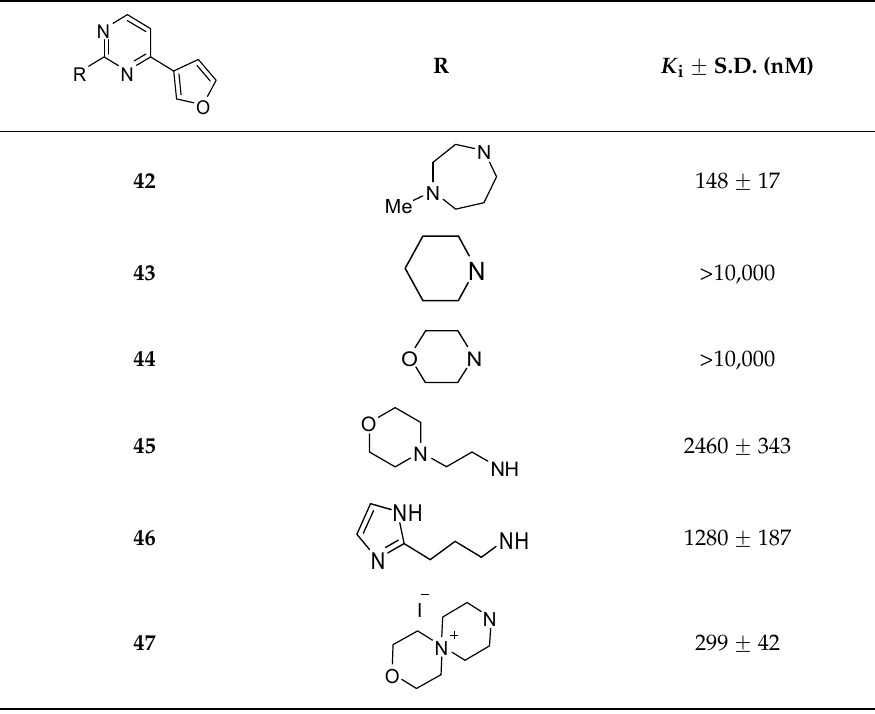
Table 2. Affinities of pyrimidines 42 – 47 for 5-HT 7 receptor.